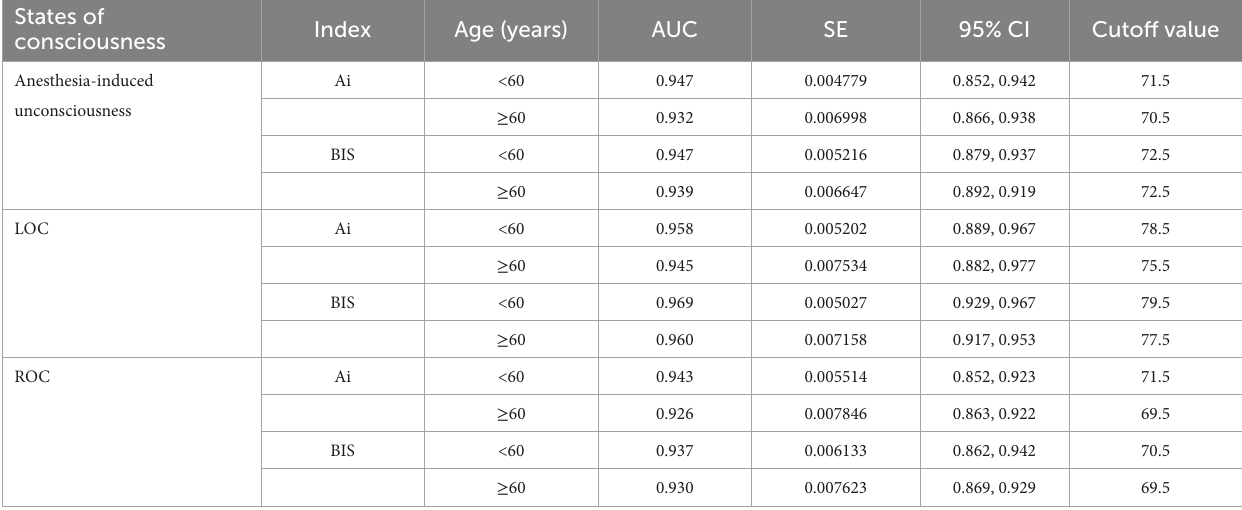
TABLE 3 Comparison of the efficacy of Ai and BIS in monitoring the different states of consciousness of patients in different age groups. States of